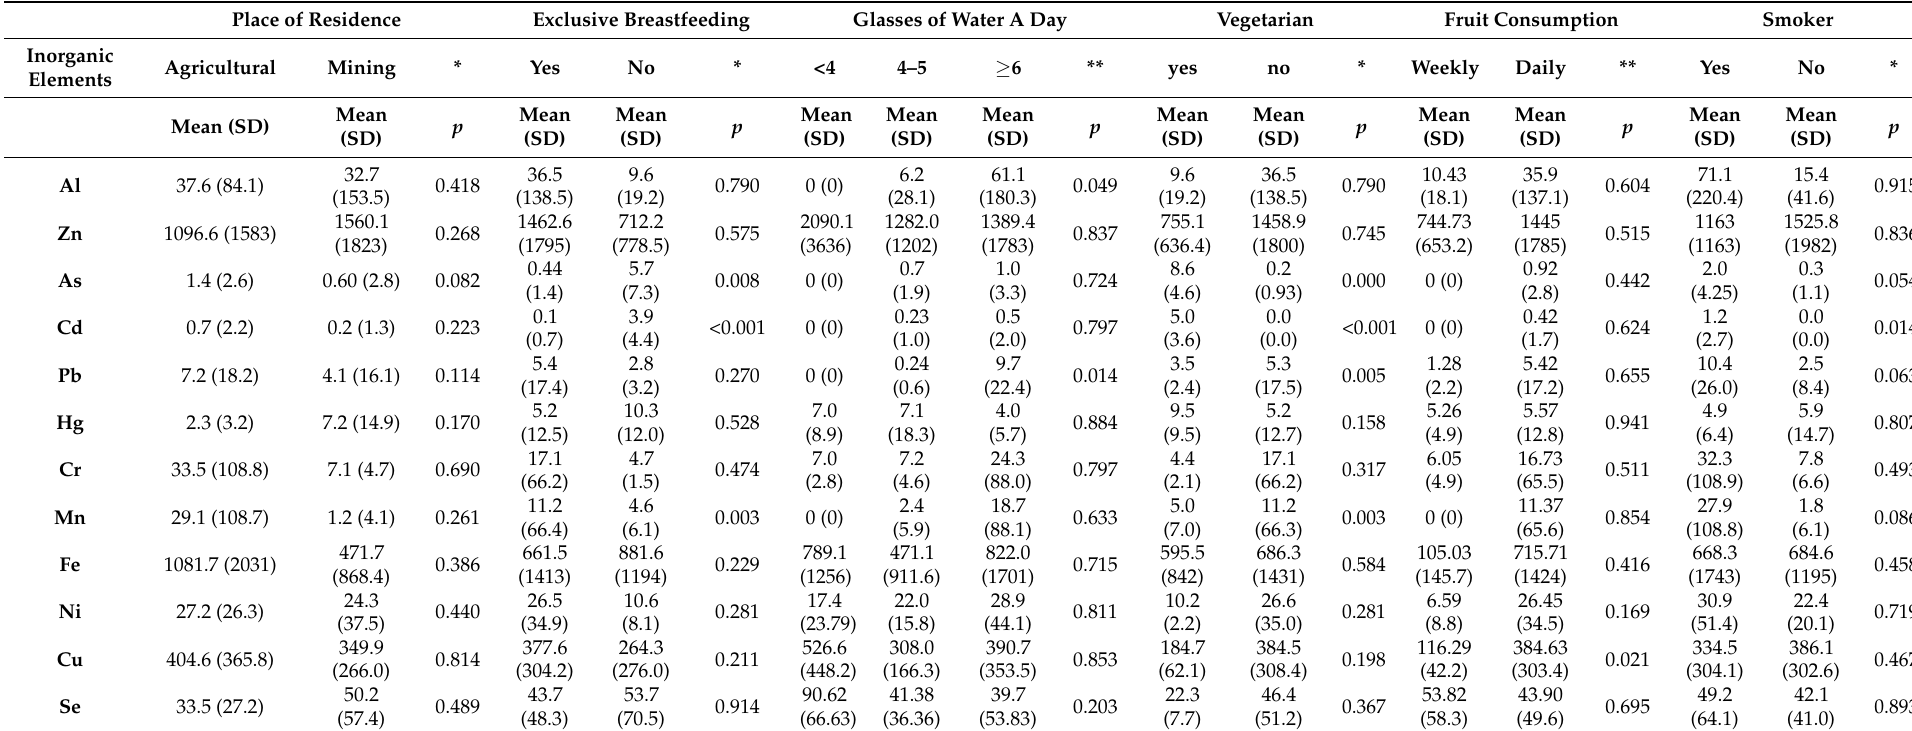
Table 4. Levels of inorganic elements in breast milk ( µ g/L) according to characteristics, diet and habits of